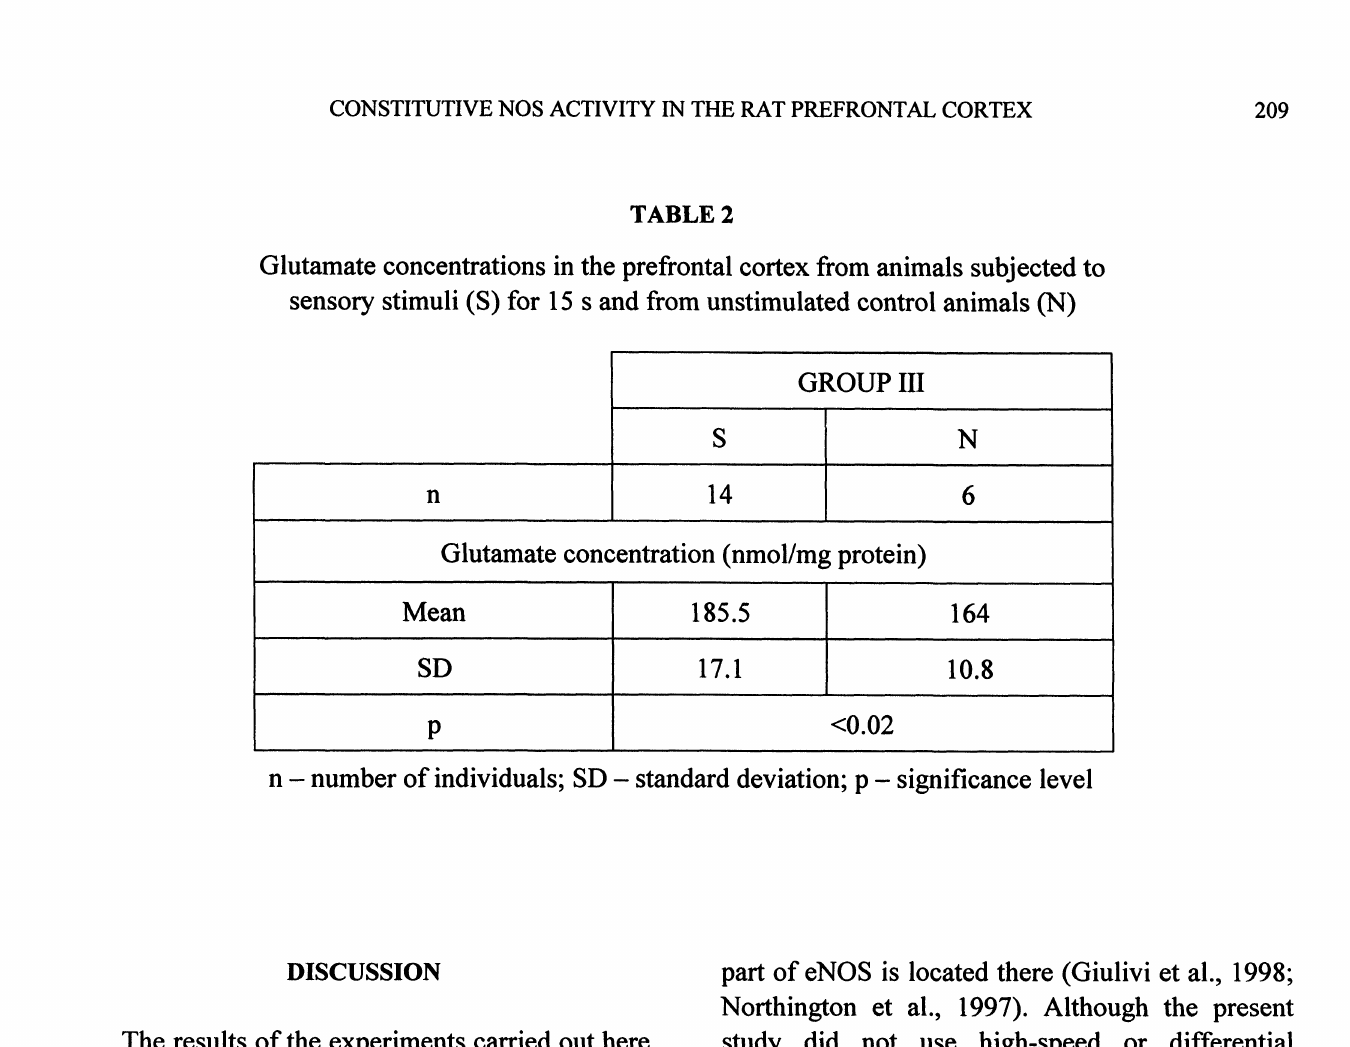
Glutamate concentrations in the prefrontal cortex from animals subjected to sensory stimuli (S) for 15 s and from unstimulated control animals